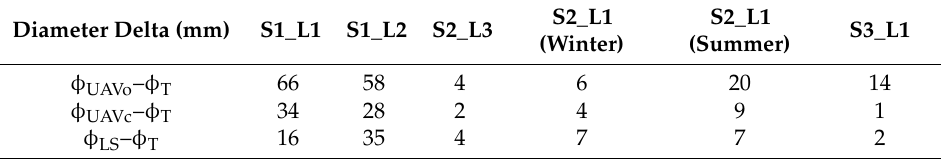
Table 7. Comparison of diameter before and after correction for UAV imagery and laser scanning data. Diameter Delta